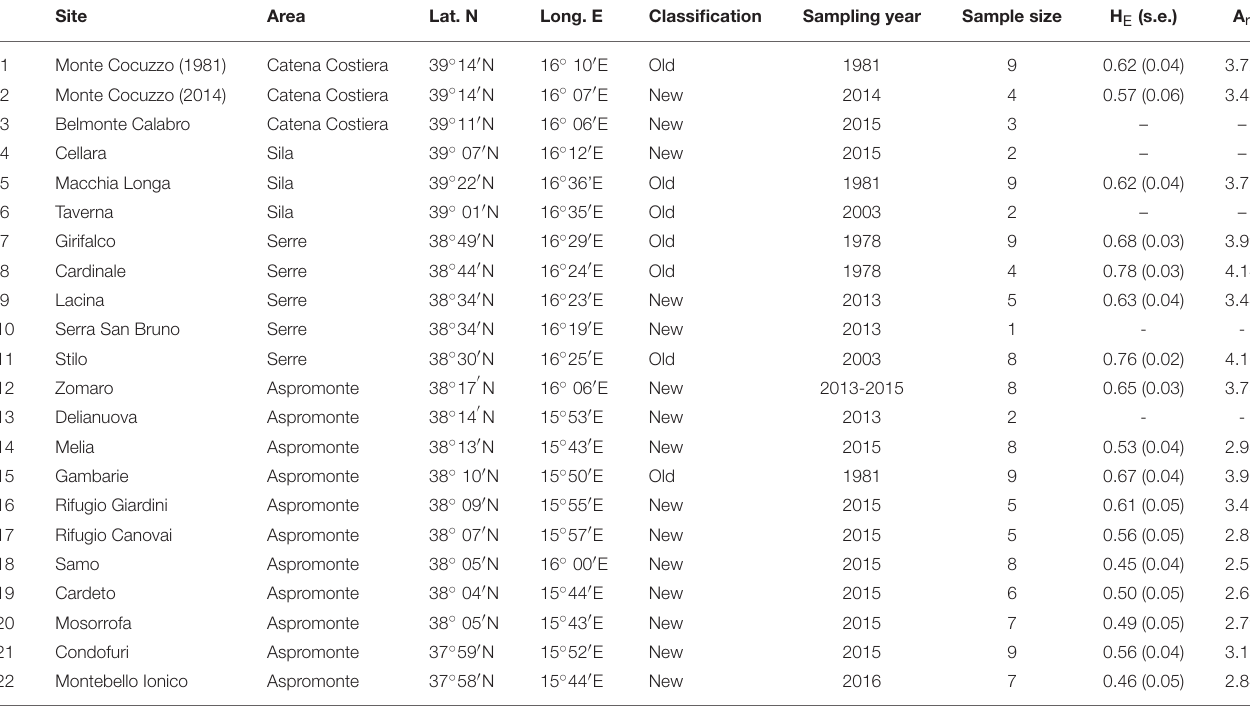
TABLE 1 | Geographic location, sample size, sampling year, and estimates of genetic diversity, for the 22 populations of Bombina pachypus sampled for the analysis of genetic variation in southern Italy.